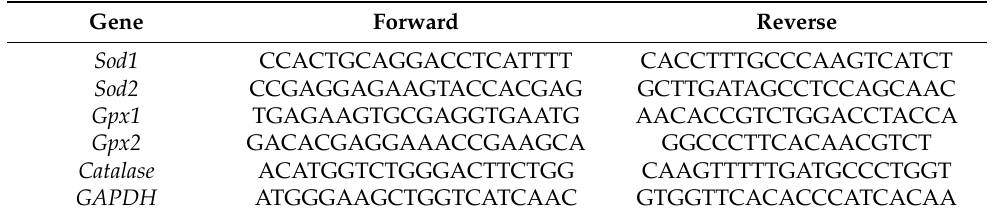
Table 3. mRNA primer